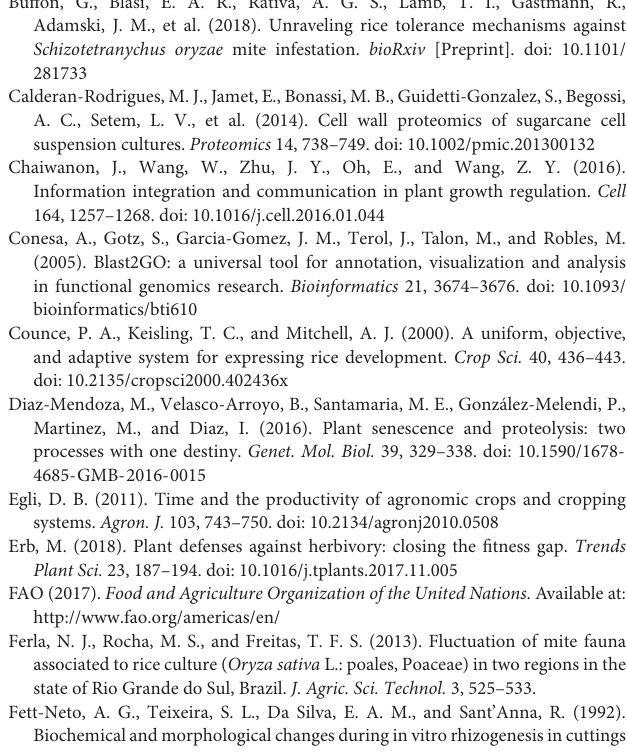
FIGURE S4 | Gene ontology annotation. Biological processes of differentially abundant and unique proteins obtained in control and EI leaves from susceptible Puitá INTA-CL and tolerant IRGA 423 cultivars. FIGURE S5 | Gene ontology annotation. Molecular functions of differentially abundant and unique proteins obtained in control and EI leaves from susceptible Puitá INTA-CL and tolerant IRGA 423 cultivars. FIGURE S6 | Relative expression levels (RT-qPCR, relative to OsUBQ5 expression) of three randomly selected genes (a) 2,3-bisphosphoglycerate-independent phosphoglycerate mutase , (b) hexokinase , (c) glutathione reductase , for which the encoded proteins were identified by proteomics as differentially abundant between the control and EI leaves from Puitá INTA-CL and IRGA 423 cultivars. Represented values are the averages of three samples ± SE. Different letters indicate that the means are different by the Tukey’s HSD test ( P ≤ 0.05). TABLE S1 | Gene-specific PCR primers used for RT-qPCR